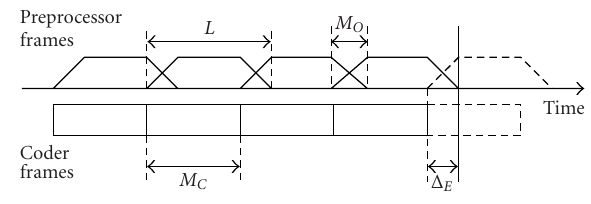
Figure 3: Frame alignment of enhancement preprocessor and speech coder with M E = M C